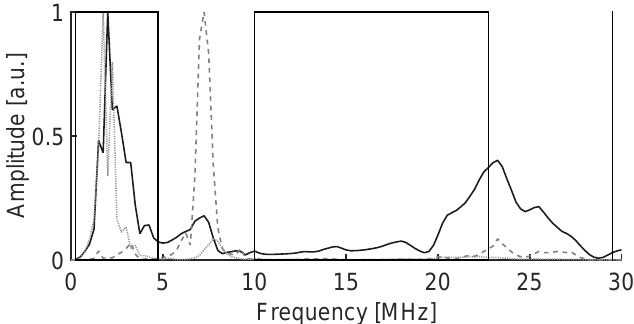
Figure 13. Spectra of the three types of signals. The dashed line corresponds to the average spectra of cluster 1, the solid line corresponds to cluster 2 and the dotted line to cluster